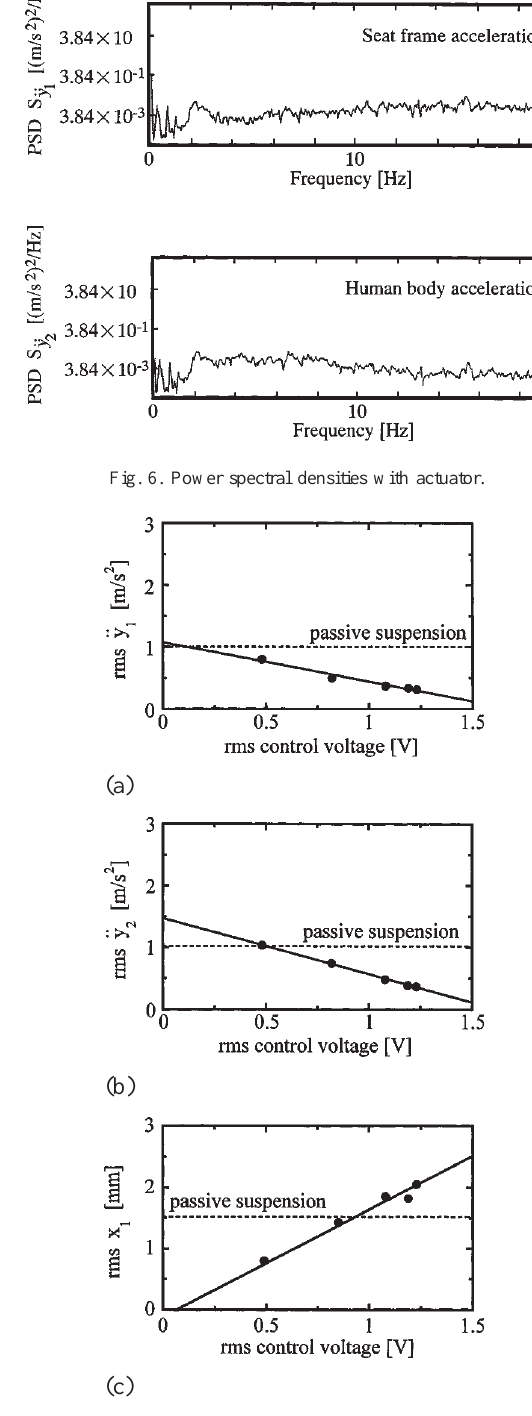
Fig. 7. Trade off curve. (a) Absolute acceleration of seat; (b) Ab- solute acceleration of hip point; (c) Relative displacement of sus-